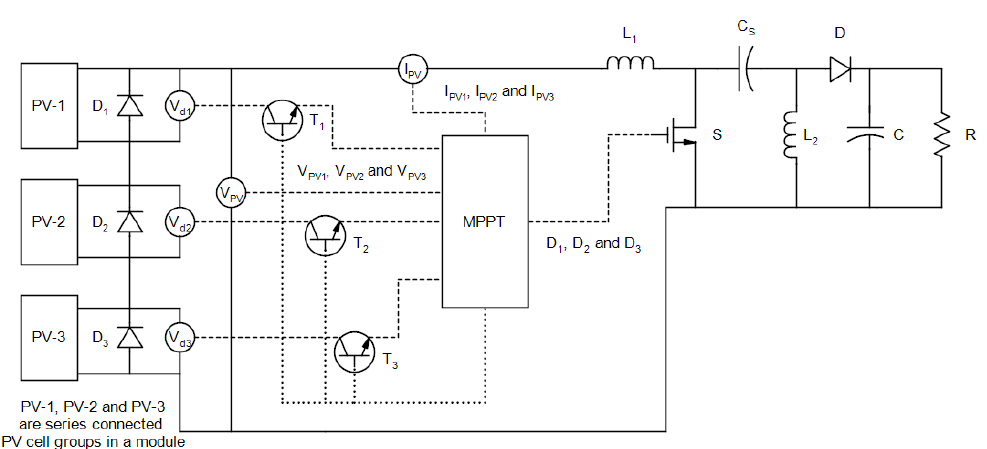
Figure 7. Circuit of the proposed maximum power point tracking (MPPT) system and micro converter.